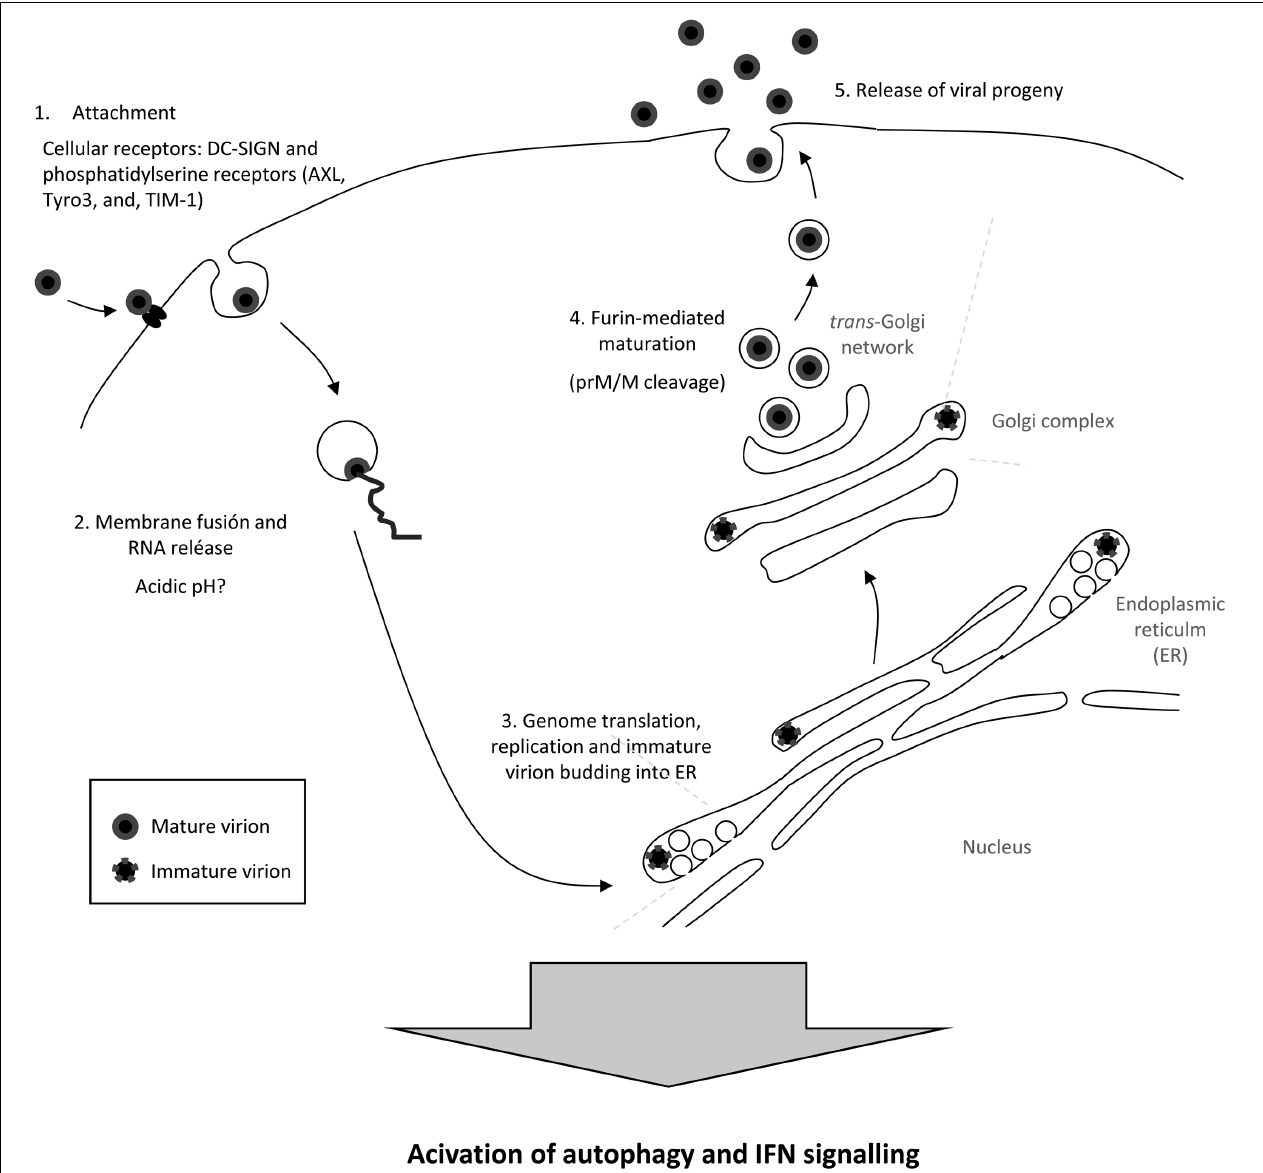
FIGURE 2 | Schematic view of the ZIKV cellular lifecycle. See text for